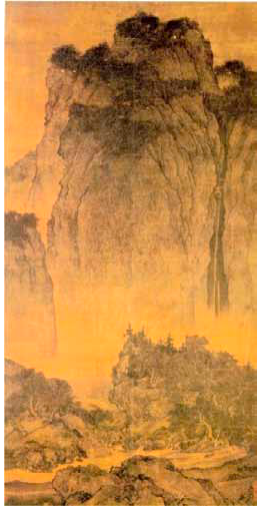
Fig. 1. Fan Kuan (960–1030), Travellers Аmong Mountains and